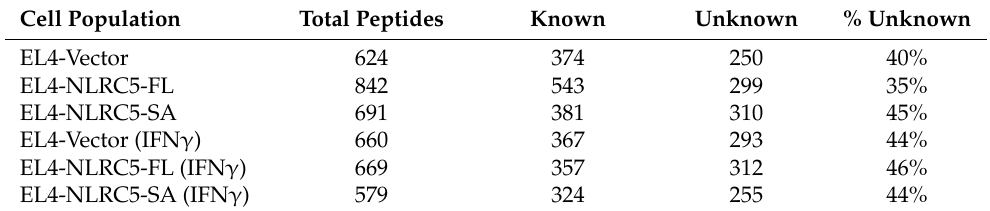
tional peptides. Table 1. Number of known and unknown 8–13aa long MAPs identi fi ed in each cell type. Table 1. Number of known and unknown 8–13aa long MAPs identified in each cell type. Cell Population Total Peptides Known Unknown Cell Population Total Peptides Known